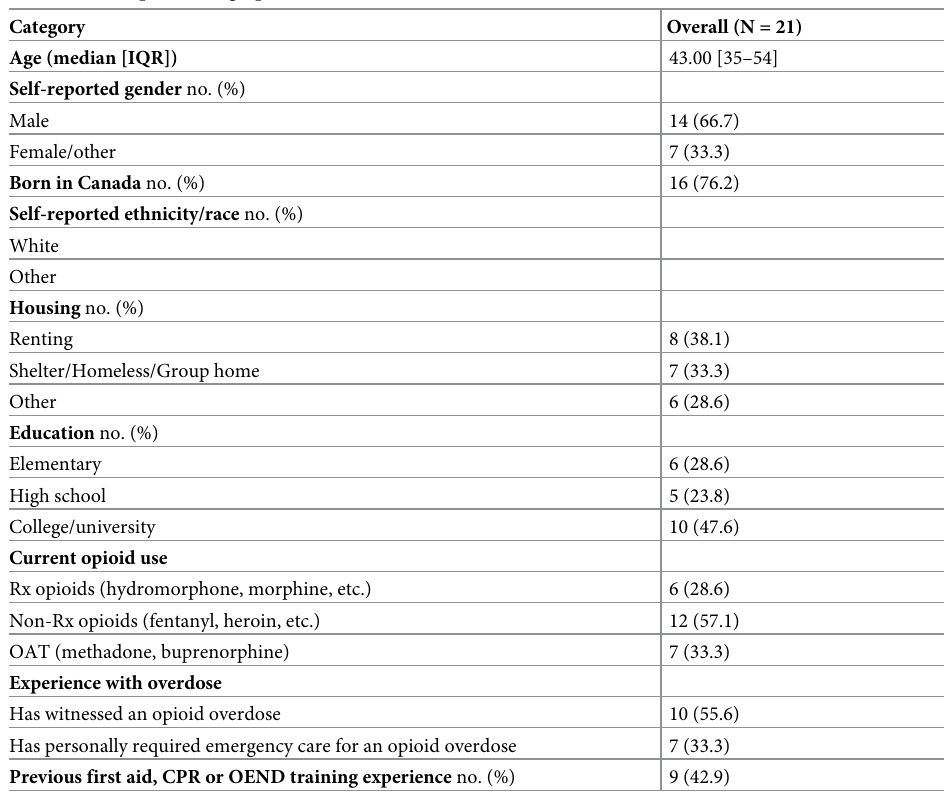
Table 1. Participant